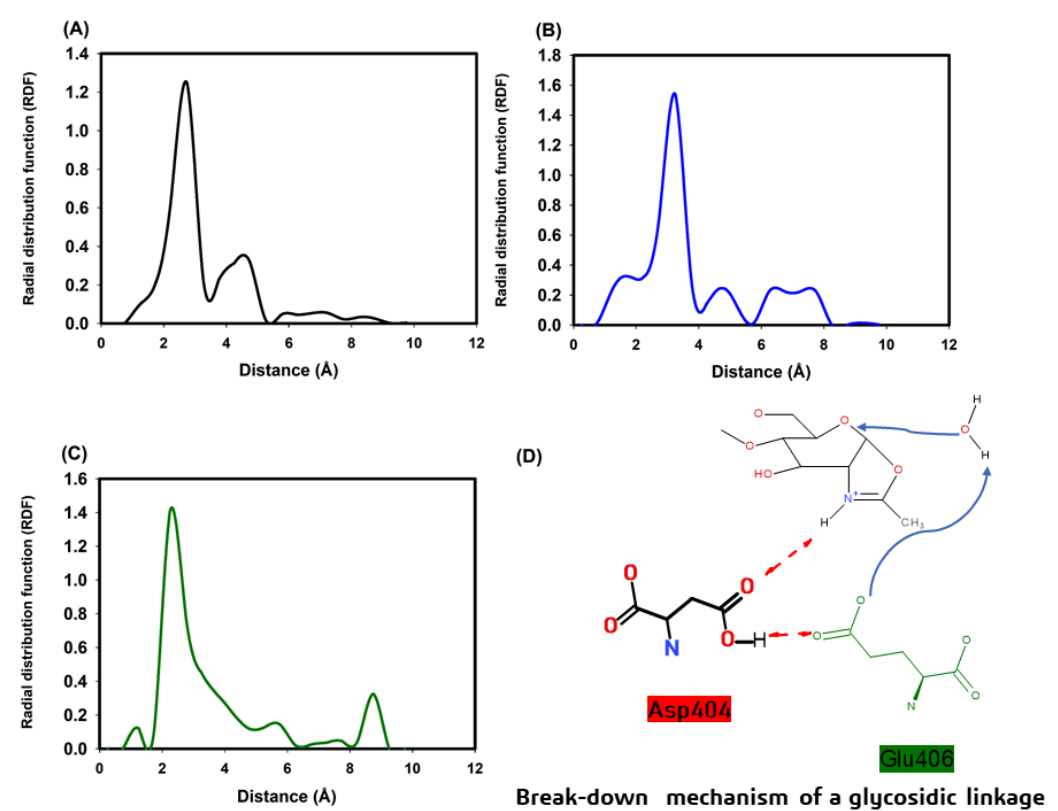
Figure 7. Radial distribution function of the chitinase 1198 DXXDXDXE motif and chitin oligomers. ( A ) Chitin repeat unit 12 in the Asp440 second GlcNAc repeat unit complex structures. ( B ) Chitin repeat unit 12 in the Asp440 third GlcNAc repeat unit complex structures. ( C ) Chitin repeat unit 3 in the Asp440 second GlcNAc repeat unit complex structures. ( D ) Breakdown mechanism of a glycosidic linkage [26,27]. Table 4. Detailed information of solvated interaction energy free energy calculations for chitinase